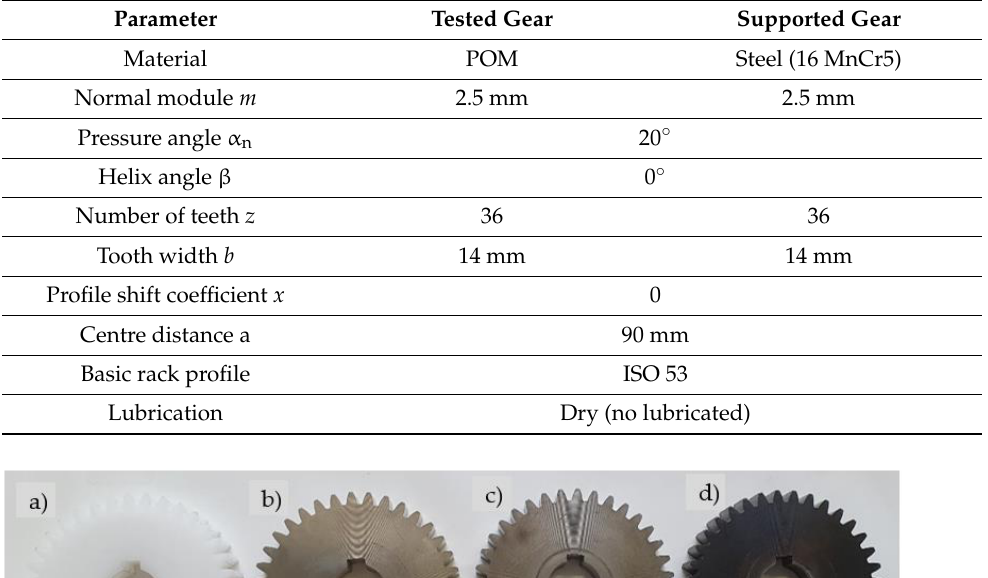
Table 2. Basic parameters of the tested gear pair.